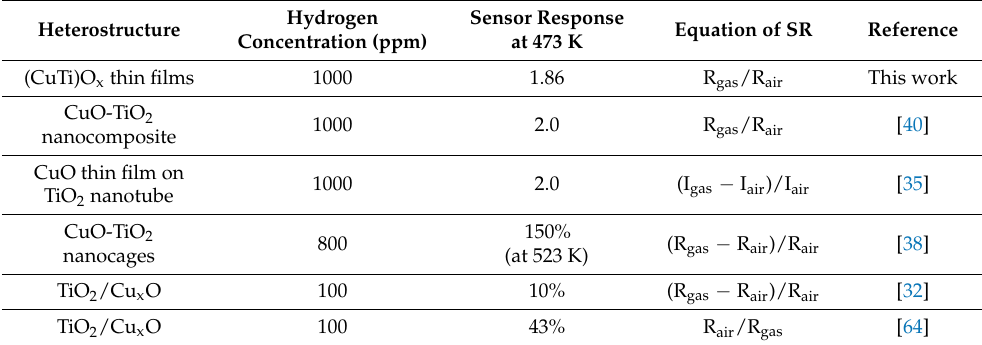
Table 2. Summary of sensor responses of nanomaterials based on copper and titanium oxides measured at a working temperature of 473 K. Hydrogen Sensor Response Heterostructure Equation of SR Concentration (ppm) at 473 K